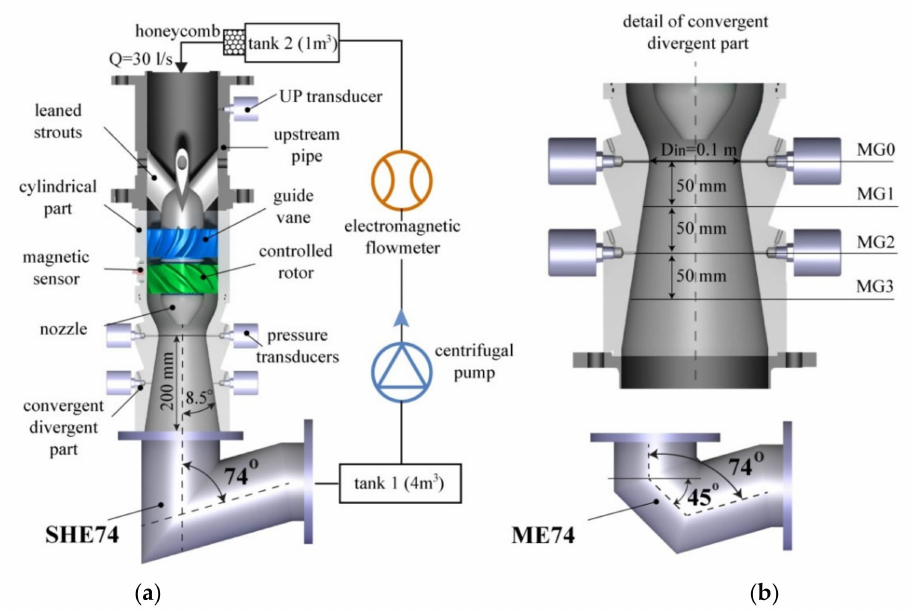
Figure 1. Schematic view of the test rig together with the test section and the elbow draft tube: ( a ) sharp heel elbow (SHE74) ( b ) detail of the convergent-divergent part with pressure sensors installed on four levels (MG0, MG1, MG2 and MG3) along the cone and the modified heel elbow